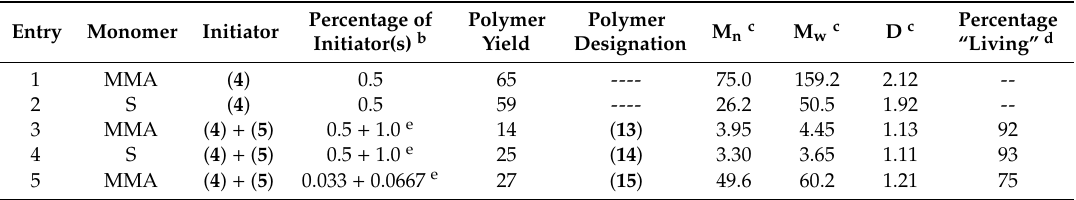
Table 1. Conditions and results for various homopolymerizations of methyl methacrylate (MMA) and styrene (S) a